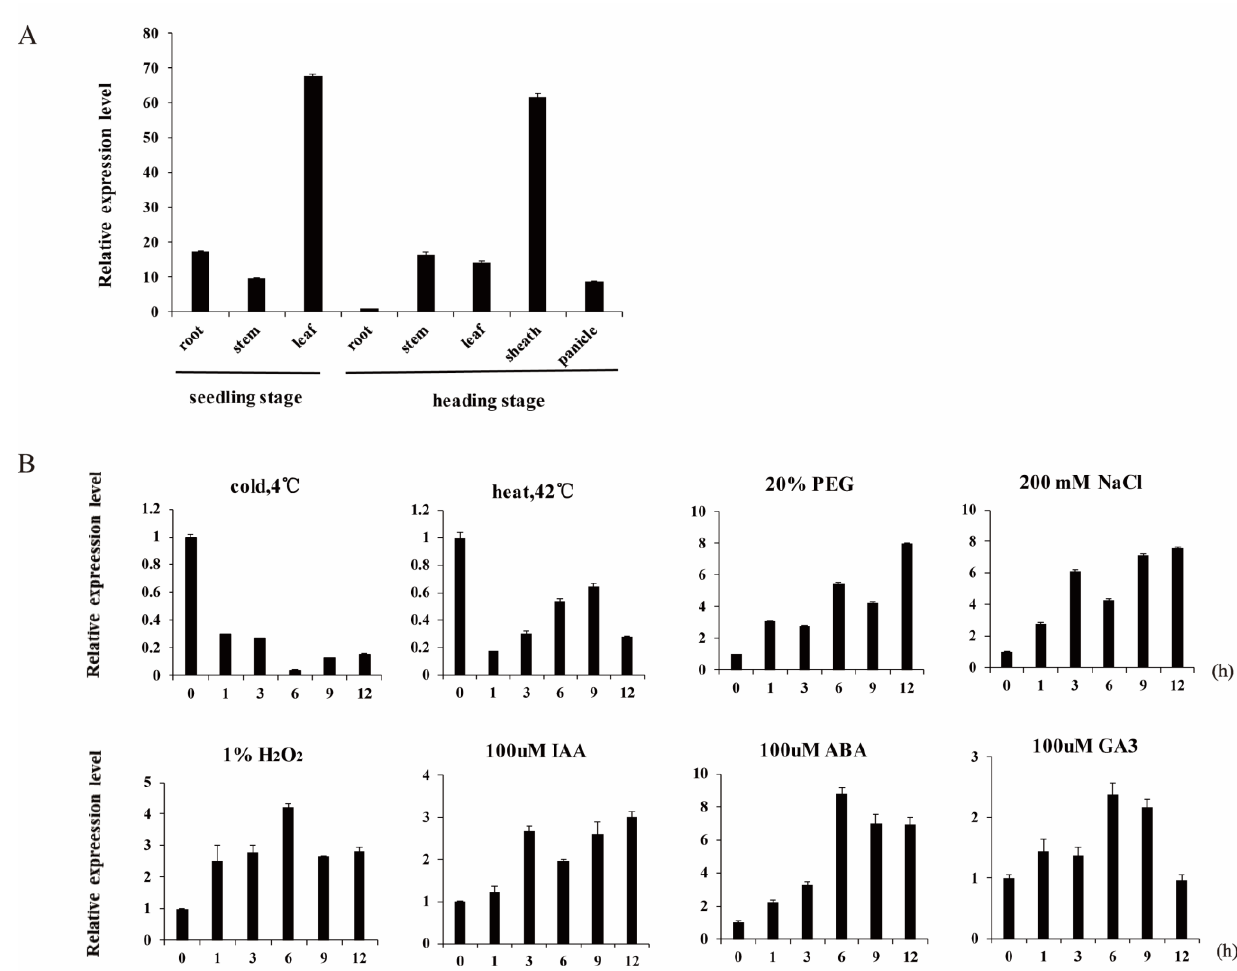
Figure 1. Expression pattern analysis of OsNAC092 . ( A ). Tissue-specific expression pattern of OsNAC092 . The X axis represents different sampling positions. Root, sheath and leaf samples at the seedling stage. Root, stem, sheath, leaf and panicle samples at the reproductive growth stage. ( B ). Expression levels of OsNAC092 under various abiotic stresses and hormone treatments. Four-week-old seedlings were subjected to treatment with cold (4 °C), heat (42 °C), PEG 6000 (20%, w/v), NaCl (200 mm), H2O2 (1%), IAA (100 μm), ABA (100 μm) and GA3 (100 μm). X axis values represent time after starting treatments. The relative expression level of OsNAC092 was measured by RT-qPCR at the indicated times. Error bars indicate SE based on three independent biological replicates.